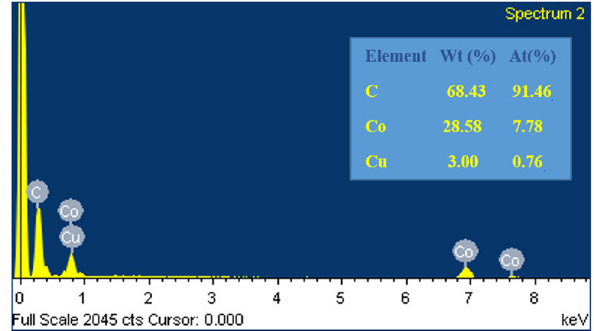
Figure A3: EDX spectra of CuCo -